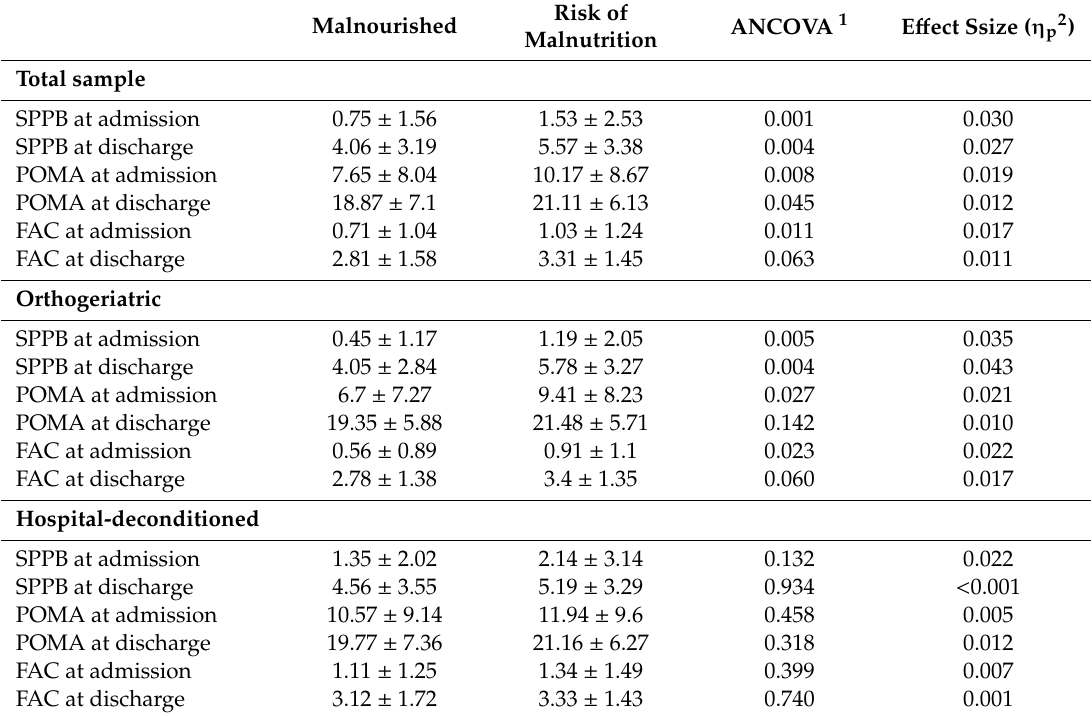
Table 4. Physical performance according to nutritional status. Risk of Malnourished ANCOVA Malnutrition